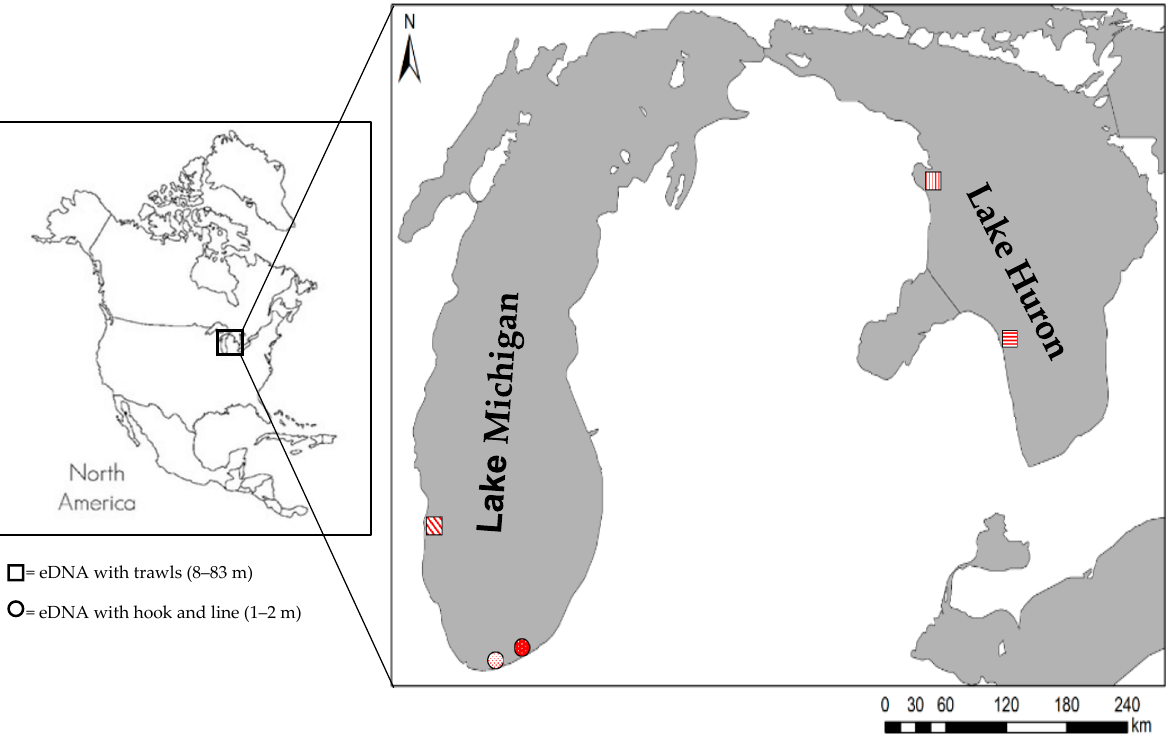
Figure 1. Locations surveyed in 2017 and 2018 for round goby ( Neogobius melanostomus ) using environmental DNA (eDNA) sampling, bottom trawling, and hook and line angling.